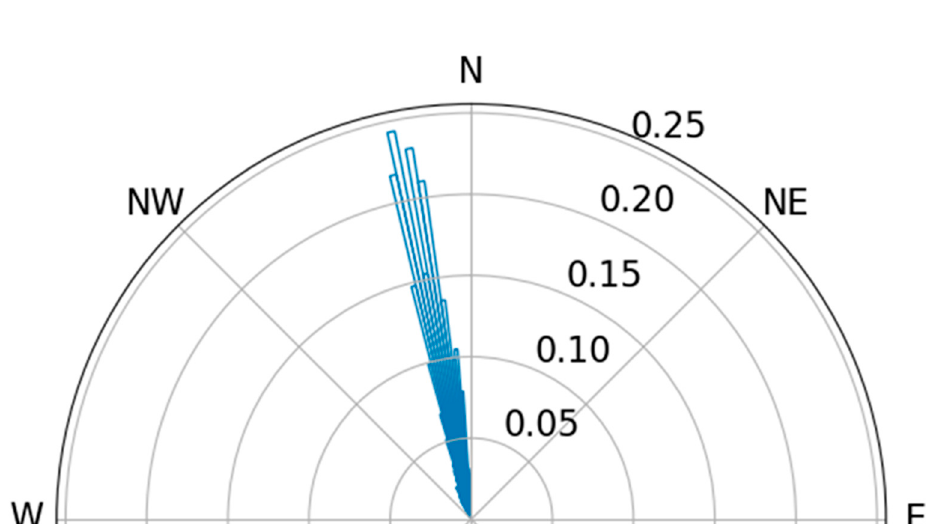
Figure 14. ( a ) Distribution of maximum relief from Carolina Bay detections across the ACP. ( b ) Distribution of area from Carolina Bay detections across the ACP.